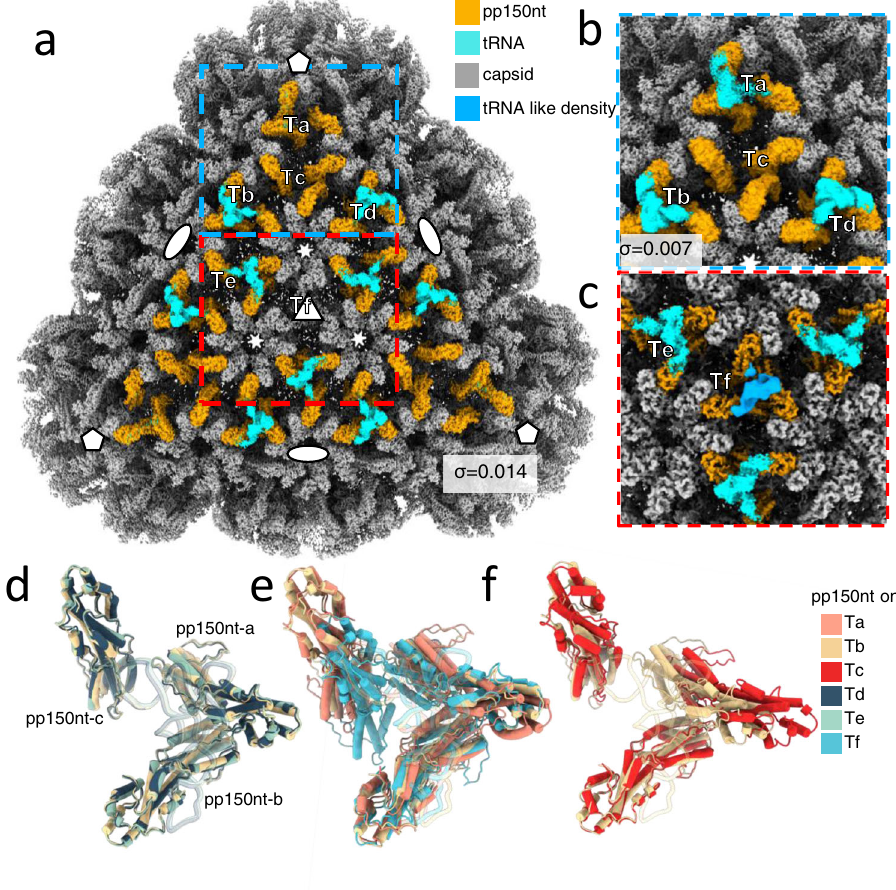
Fig. 4 Distribution of tRNA on different triplexes. a A facet of the icosahedron of HCMV reconstruction. b , Enlarged view of the region in the blue dashed box in a but displayed with a lower threshold. Ta ’ s tRNA-like density becomes visible at a lower threshold. No tRNA binds on Tc. σ represents the threshold used to display 3D structures. c Asymmetric reconstruction (e.g., C1) of the region in the red dashed box in a . Tf ’ s tRNA-like density becomes visible at a lower threshold. d – f Set-of-three pp150 shown as pipes and planks from different triplex areas are superimposed. tRNAs are shown as semi-transparent ribbons. Superimposition among set-of-three pp150 and their corresponding bound tRNA molecules on Tb, Td, and Te ( d ); on Ta, Tb, and Tf ( e ); and on Tb and Tc regions ( f ). The change in pp150 organization affects the ability of tRNA to bind to the